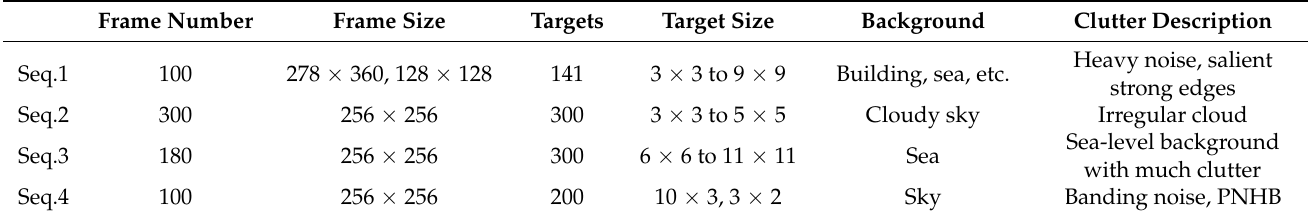
Table 1. The details of four real image sequence.